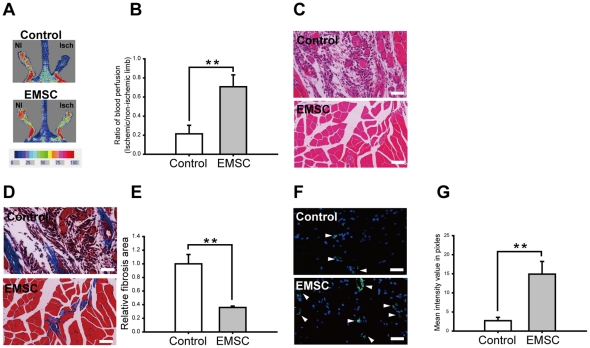
Transplanted EMSCs improved blood perfusion in ischemic limb.(A) Foot perfusion was evaluated by laser Doppler blood perfusion analysis at day 7 post ischemia. In color-coded images, red represents normal perfusion, while dark blue represents low or absent perfusion. (B) Quantification of the foot perfusion showed that EMSCs (at the fifth passage) transplantation significantly improved blood perfusion (n = 3). (C) H&E staining showed massive muscle degeneration in ischemic regions in the control group compared to the markedly reduced muscle degeneration in the EMSCs group. (D) Masson's Trichrome staining and (E) its quantification showed significantly larger fibrotic area in the control group than the EMSCs injected group. (F) Immunostaining of von Willebrand factor (vWF) of ischemic limb muscle and (G) its quantification showed significantly more vWF expressed cells (arrowhead) in the EMSCs injected group than the control group. Scale bars represent 100 µm. **represents P<0.01. Data are presented as mean ± s.d. and analyzed with Student's t-test. Isch: ischemic limb; NI: non-ischemic limb; Control: complete medium injection-group; EMSC: EMSCs-injection group.